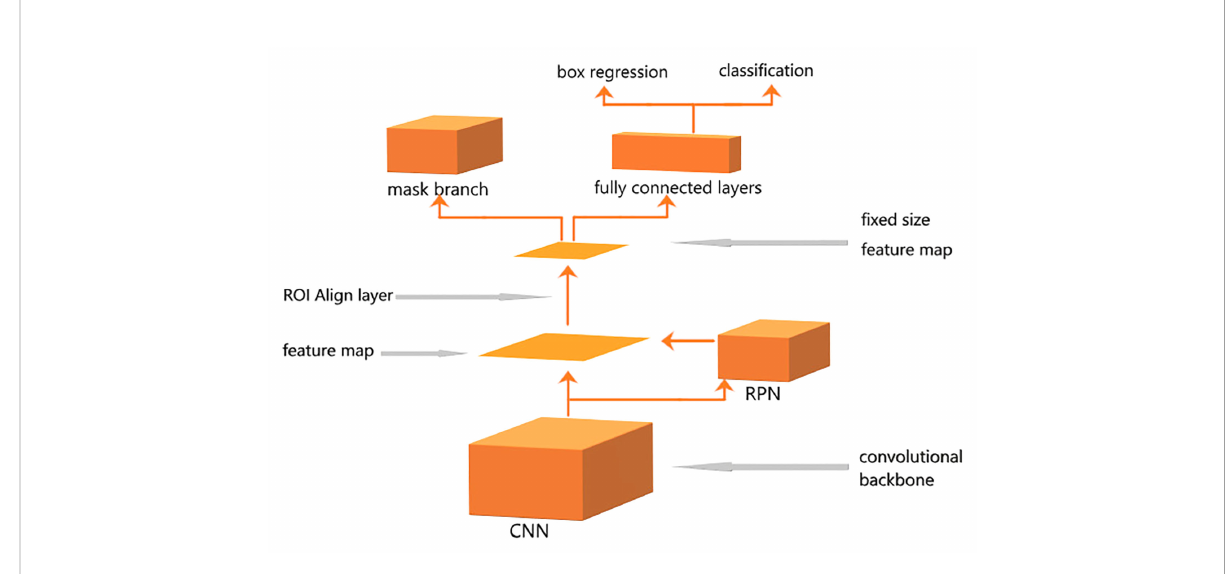
FIGURE 5 Mask region-based convolutional neural network